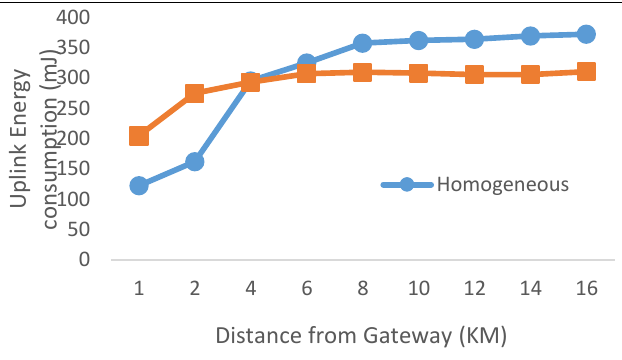
Figure 6: Uplink energy consumption with